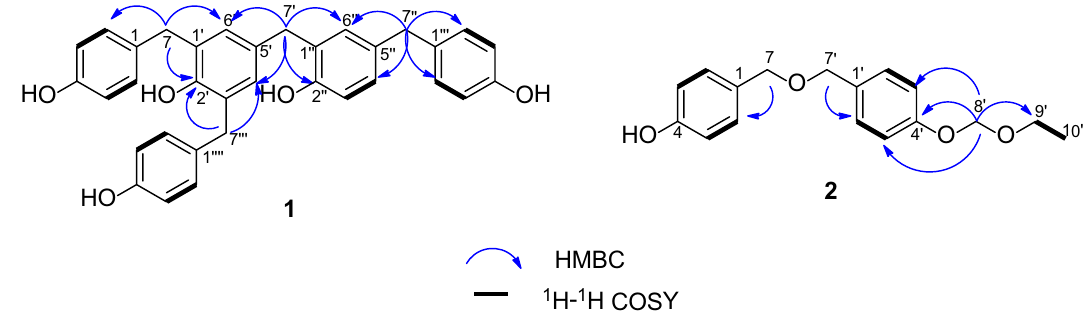
Fig. 2 The key 1 H- 1 H COSY and the HMBC correlations of compounds 1 and 2